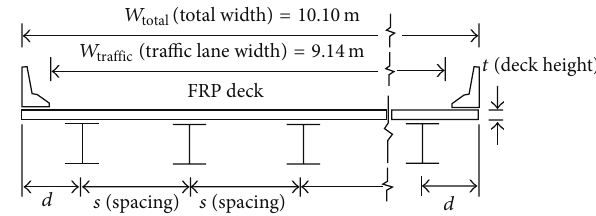
Figure 2: Typical bridge model